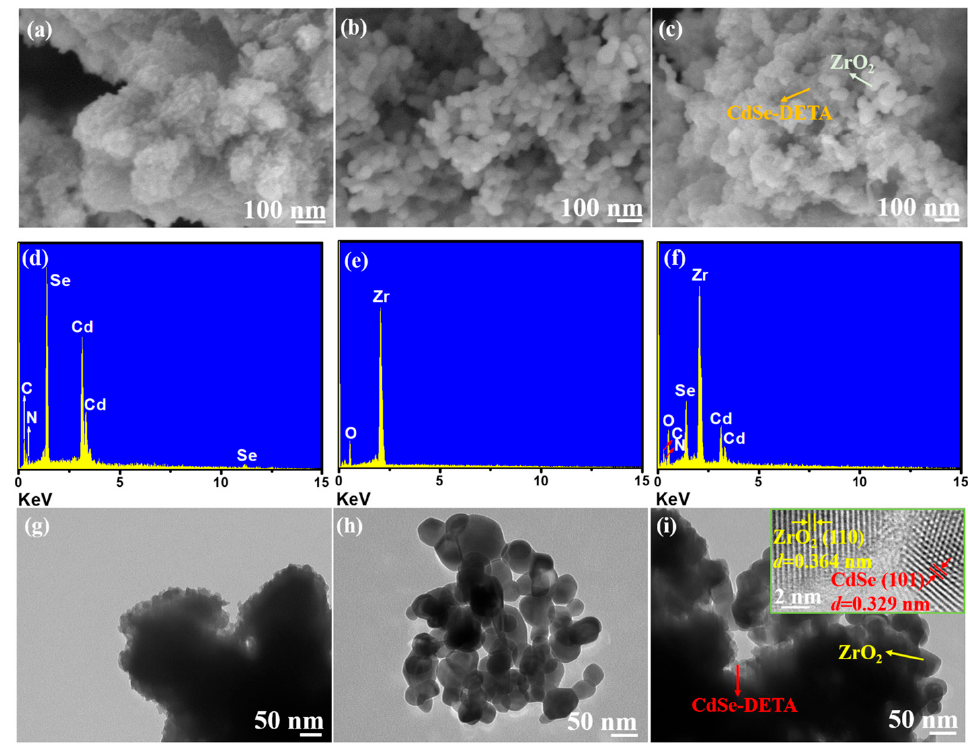
Figure 2. SEM images of ( a ) CS, ( b ) ZO, and ( c ) ZO/CS − 0.6; EDS spectra of ( d ) CS, ( e ) ZO, and ( f ) ZO/CS − 0.6. TEM images of ( g ) CS, ( h ) ZO, and ( i ) ZO/CS − 0.6 (inset shows the HRTEM images of the ZO/CS − 0.6).